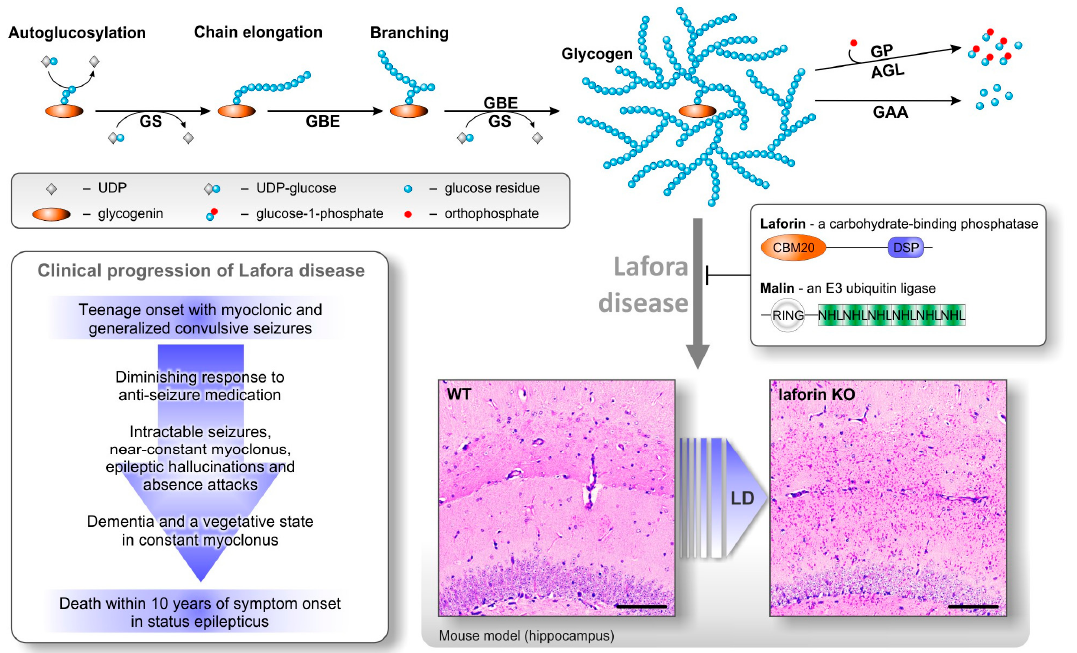
Figure 1. Lafora disease (LD) in the context of glycogen metabolism. Synthesis of glycogen molecules in the cytosol (top row) essentially includes autoglucosylation of glycogenin, elongation of chains by glycogen synthase (GS), and introduction of branching points by glycogen branching enzyme (GBE). The regularly branched and water-soluble glycogen molecules are degraded by glycogen phosphorylase (GP) and glycogen debranching enzyme (AGL, indirect debranching) in the cytosol or by lysosomal enzymes such as acid α -glucosidase (GAA). Functional laforin and malin essentially inhibit the formation of Lafora bodies and prevent LD as indicated by the inhibitory arrow. Mutations leading to non-functional laforin or malin (protein domains explained in the text) result in formation and accumulation of Lafora bodies as exemplarily shown in brain sections of the laforin-deficient mouse model (bottom right, scale bar equals 100 µ m). In humans, LD manifests in an eventually fatal progression of clinical symptoms (bottom left).